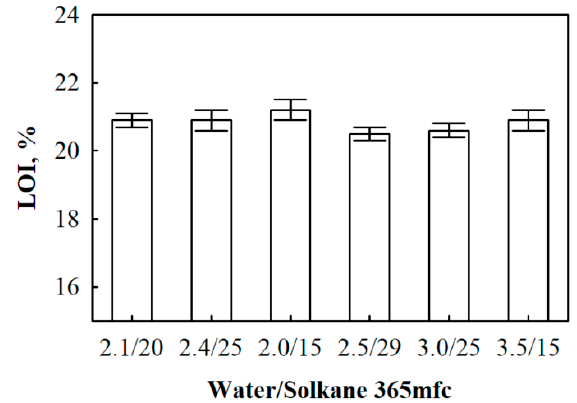
Figure 8. Limited oxygen index (LOI) test results for polyurethane foam with different water/Solkane 365 mfc ratios.